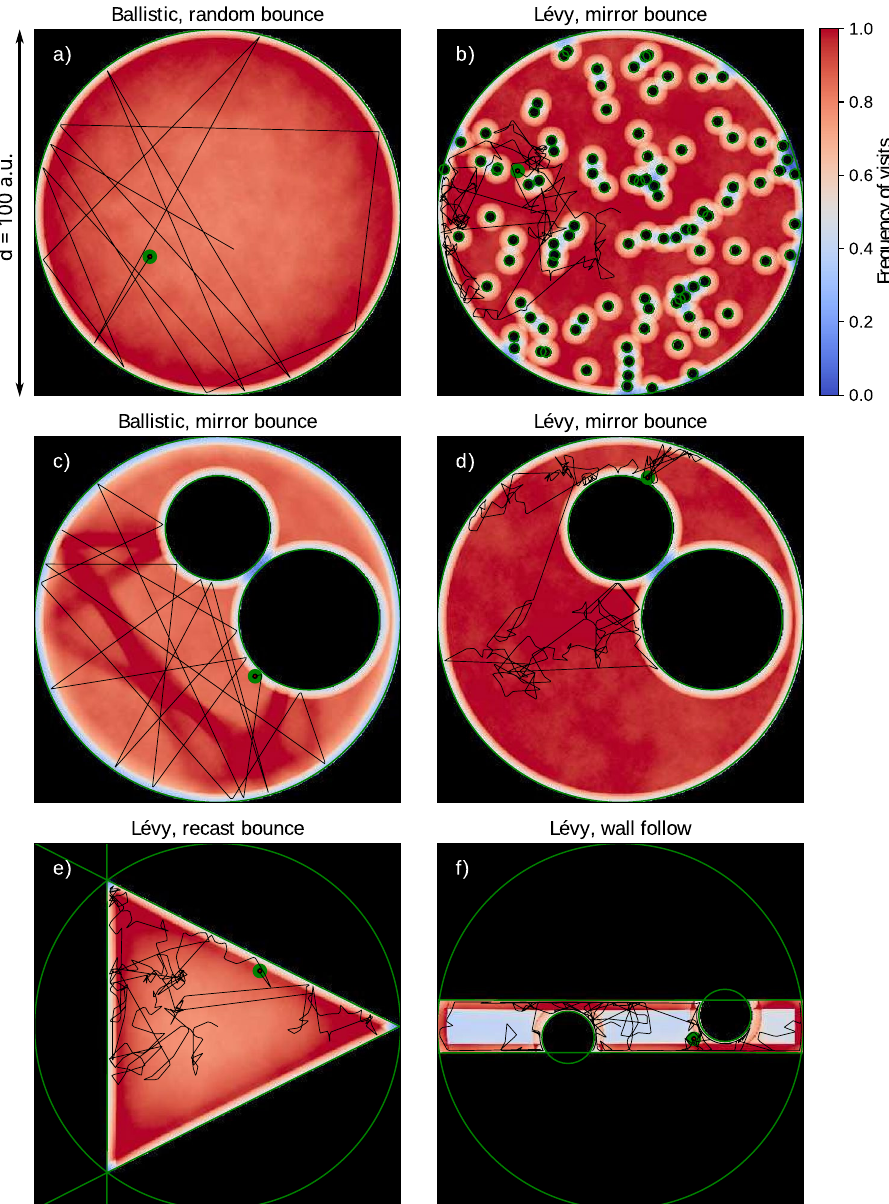
Figure 5. Exploration redundancy represented by heat maps of revisit frequency for a set of search strategies and environments. Panels correspond to: ( a ) Plain map and ballistic random bounce, ( b ) Dense Forest map and Lévy mirror bounce, ( c ) craters map and ballistic mirror bounce, ( d ) Craters map and Lévy mirror bounce, ( e ) Triangle map and Lévy recast bounce, ( f ) Corridor map and Lévy wall follow. Representative trajectories 4 are depicted in black for each map ( 10 steps). The supplementary material includes a video animation (Supplementary Video 1) depicting the evolution of this metric for the Craters map with strategies: Ballistic random bounce, Lévy mirror bounce, Brownian with memory, and uninformed